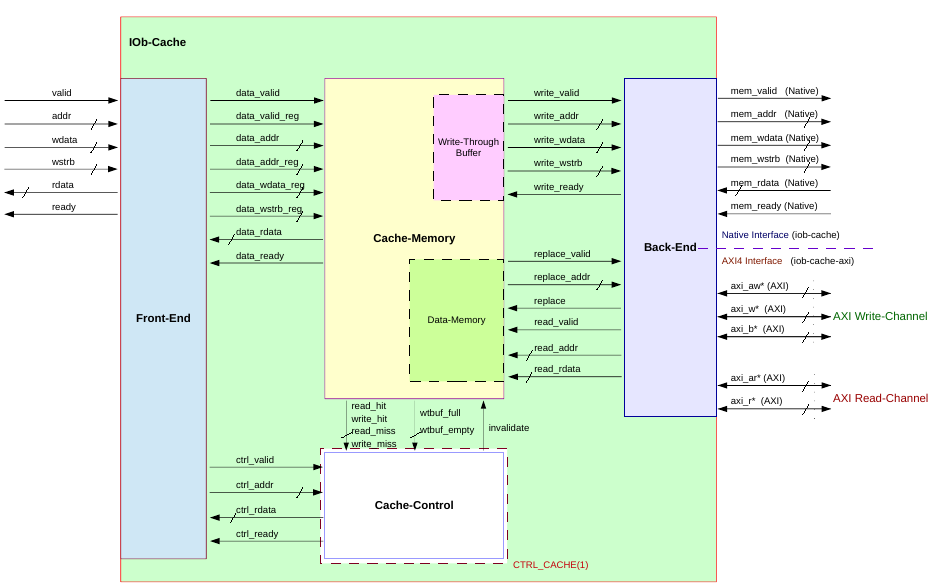
Figure 1. IOb-Cache top-level module